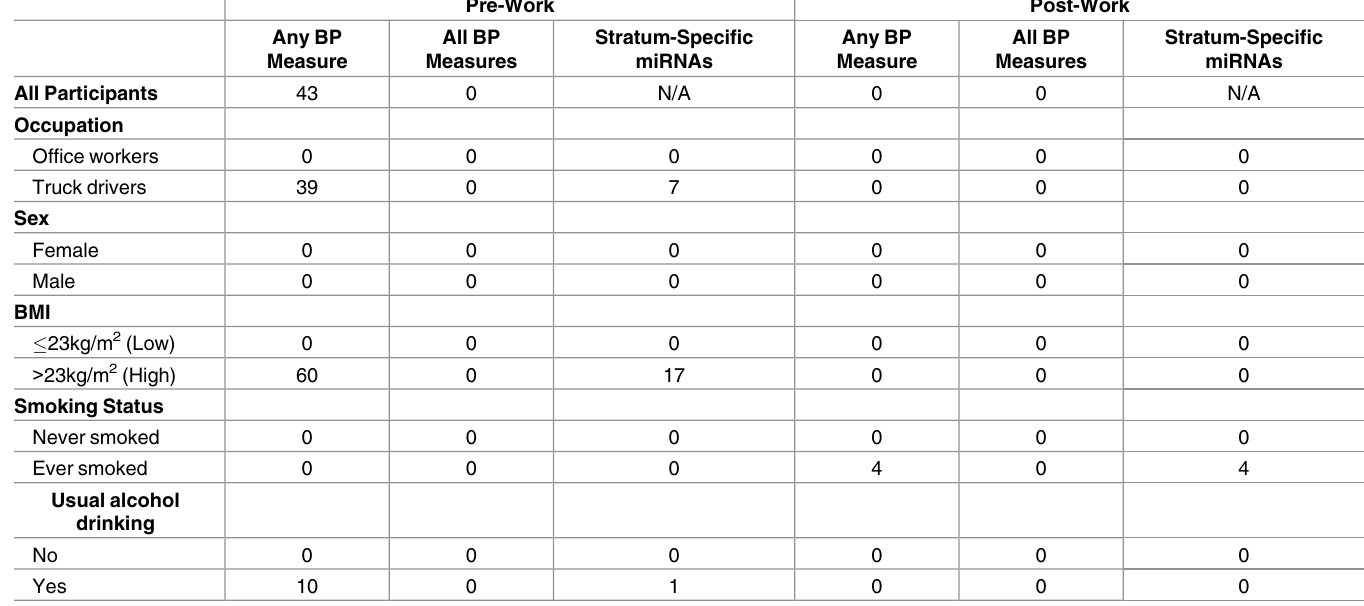
Table 3. Number of miRNAs associated with BP measuredpre- and post-work, in all participants and by strata of occupation and characteristics at FDR <